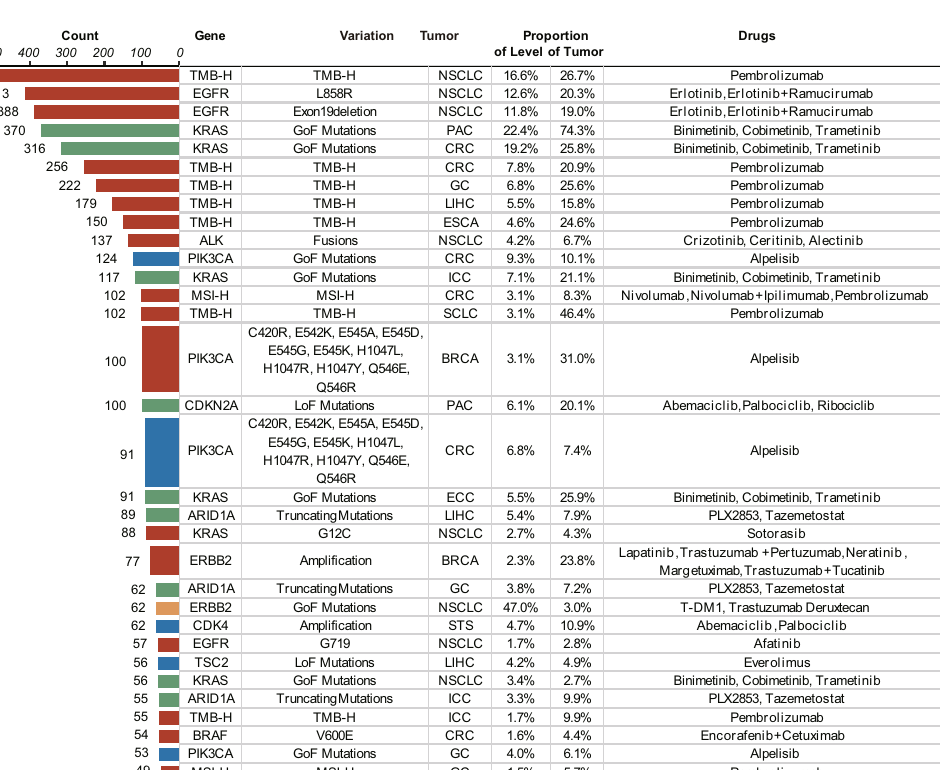
Fig. 4 Clinical actionability of somatic alterations in the OM cohort. a Variants were assigned to different levels of clinical actionability according to OncoKB. The distribution of the highest level of actionable variants across all patients was shown in the pie chart. The colors representing each level were used throughout the other panels in this fi gure. b Distribution of highest level of actionable variants across tumor types. c Details of the 30 most common actionable variants, proportions of levels in corresponding tumor types, and their potential sensitive drugs. The numbers of patients in each level were shown in the bar graph. The right table showed genes, variants, and the tumor type for each level of clinical actionability, as well as the proportion of patients in the corresponding tumor type and level. Potential sensitive drugs suggested by biomarkers were also shown in the